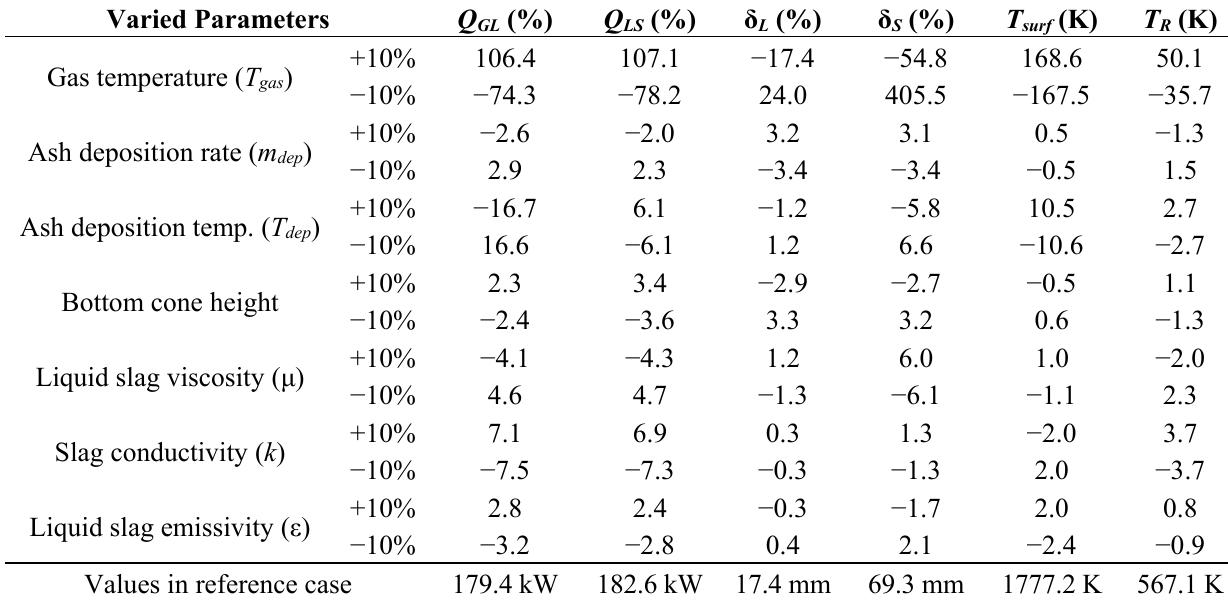
Table 2. Changes in key output values for ±10% variations in input parameters from the reference case ( Q GL and Q LS : integrated over the entire wall; δ L , δ S , T surf , and T R : at the slag tap). Varied